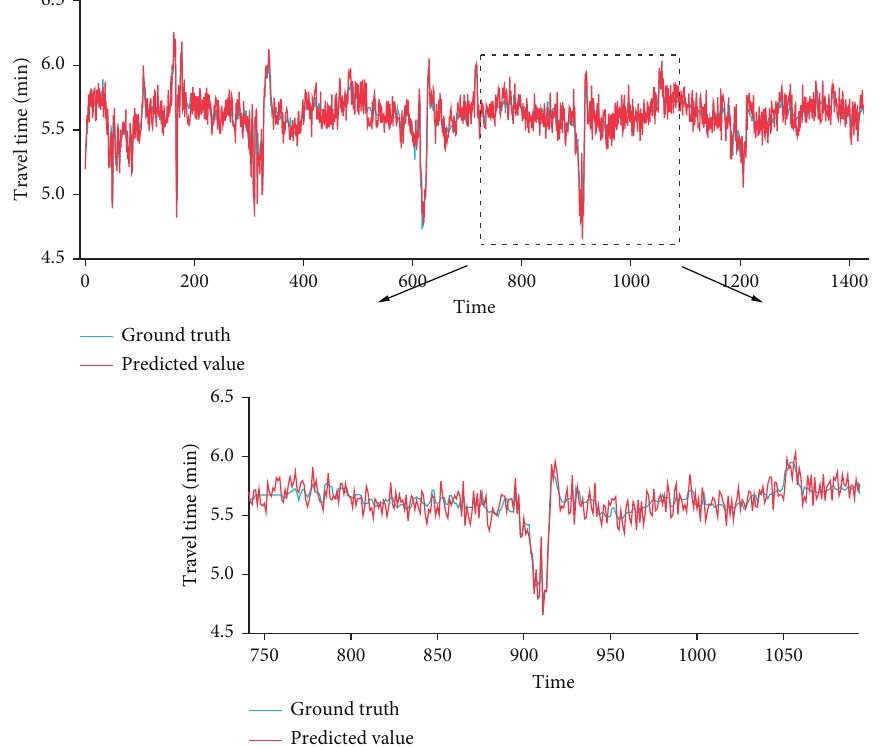
Figure 9: Prediction result of segment